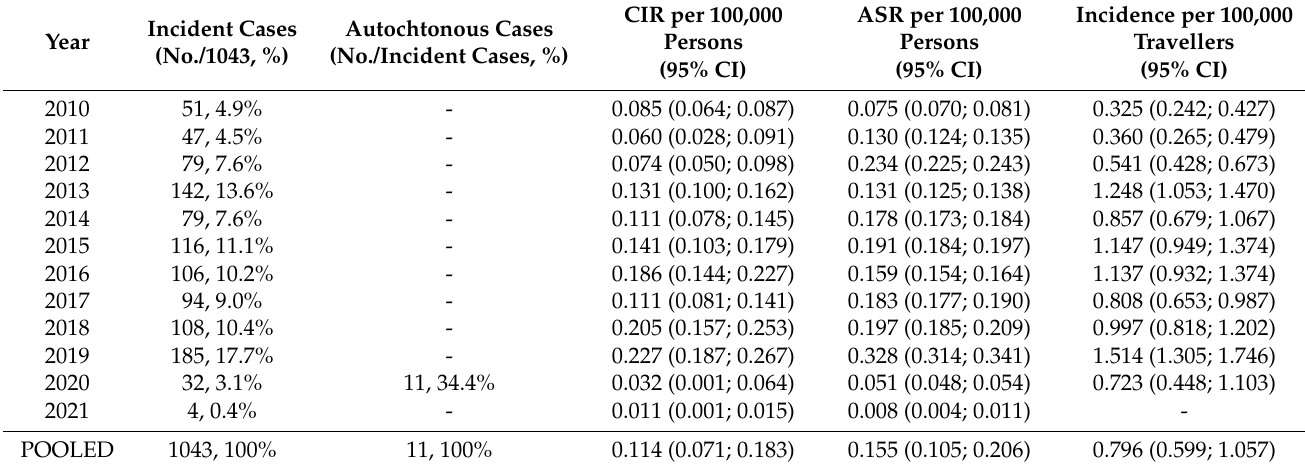
Table 2. Notification rates for cases of dengue in Italy (2010–2021). Crude incidence rates (CIR) were estimated assuming the total Italian population as the reference. Age-adjusted standardized rates (ASR) with their respective 95% confidence intervals (95% CI) were calculated assuming standard European Population as the reference. Incidence in travelers was calculated through official data of Italian Institute for Statistics on Travelers in countries other than European Union